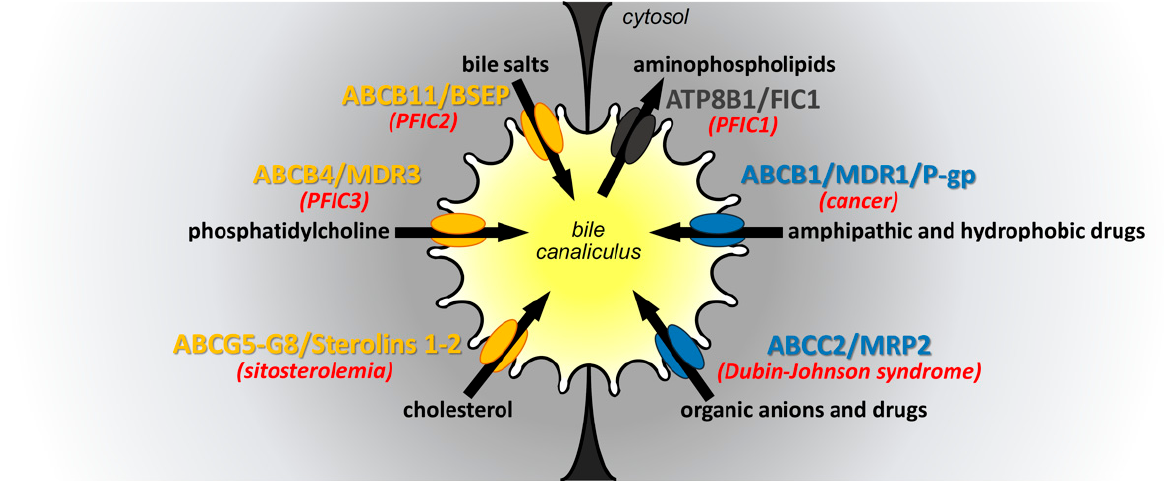
Figure 1. ATP-binding cassette (ABC) transporters at the canalicular membrane of hepatocytes. The bile canaliculus is formed by the canalicular membrane of hepatocytes. The main canalicular ABC transporters are indicated according to the nature of their substrates: in yellow for hydrophobic substrates and in blue for drugs. Note that ATP8B1 is not an ABC transporter but a P-type ATPase. However, its function is tightly related to the other canalicular ABC transporters. The substrates of these transporters are shown in black, and their flows are indicated by black arrows. The main diseases associated with functional defects of these transporters are indicated in red. PFIC: progressive familial intrahepatic cholestasis.